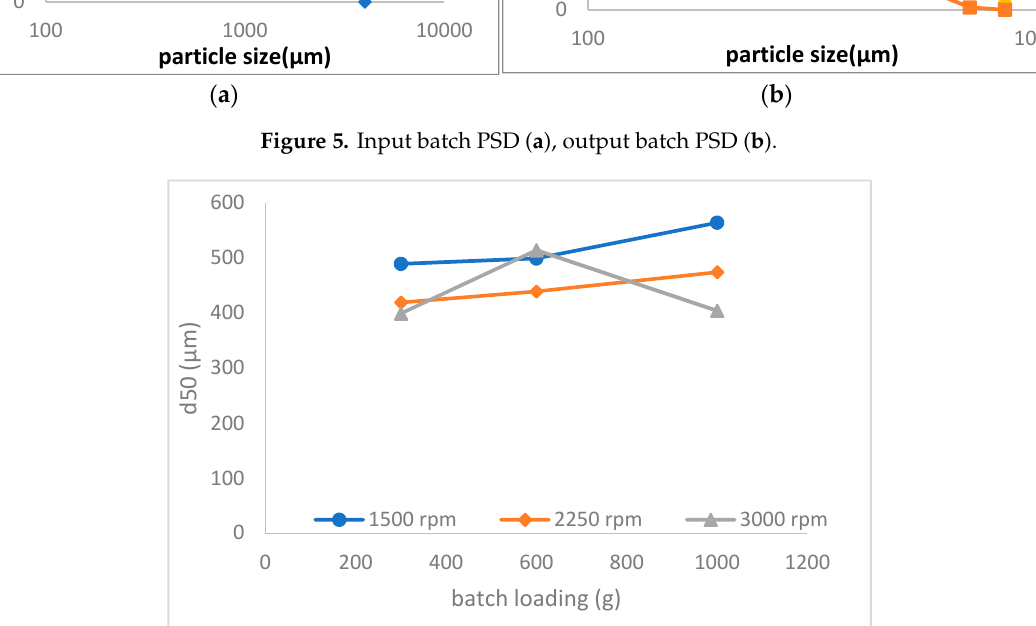
Figure 6. Plot showing the effect of batch loading on milled product d50 at different impeller speeds.